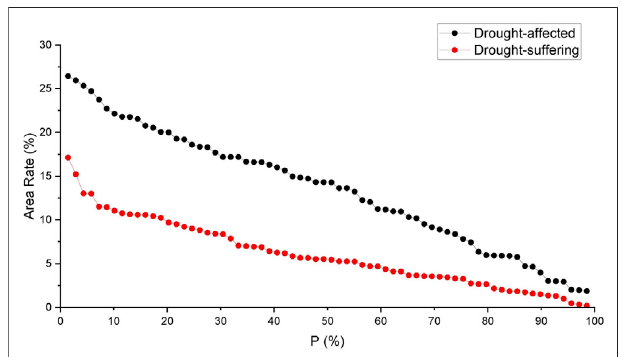
FIGURE 2 | Frequency curves of drought-affected area and drought- suffering area in